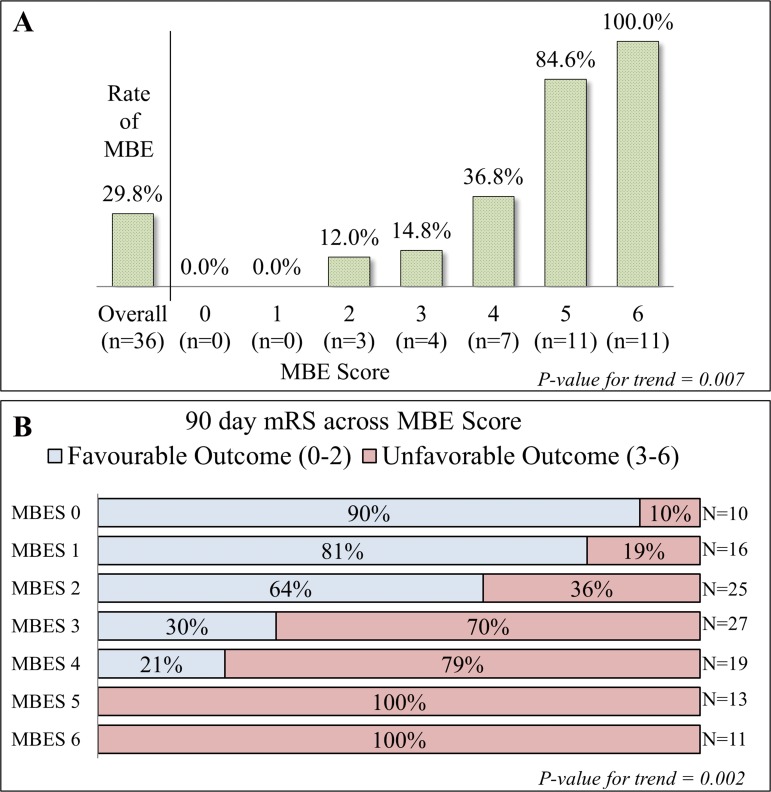
(A) Rate of MBE across MBESs. (B) 90 day mRS score distribution across MBESs.